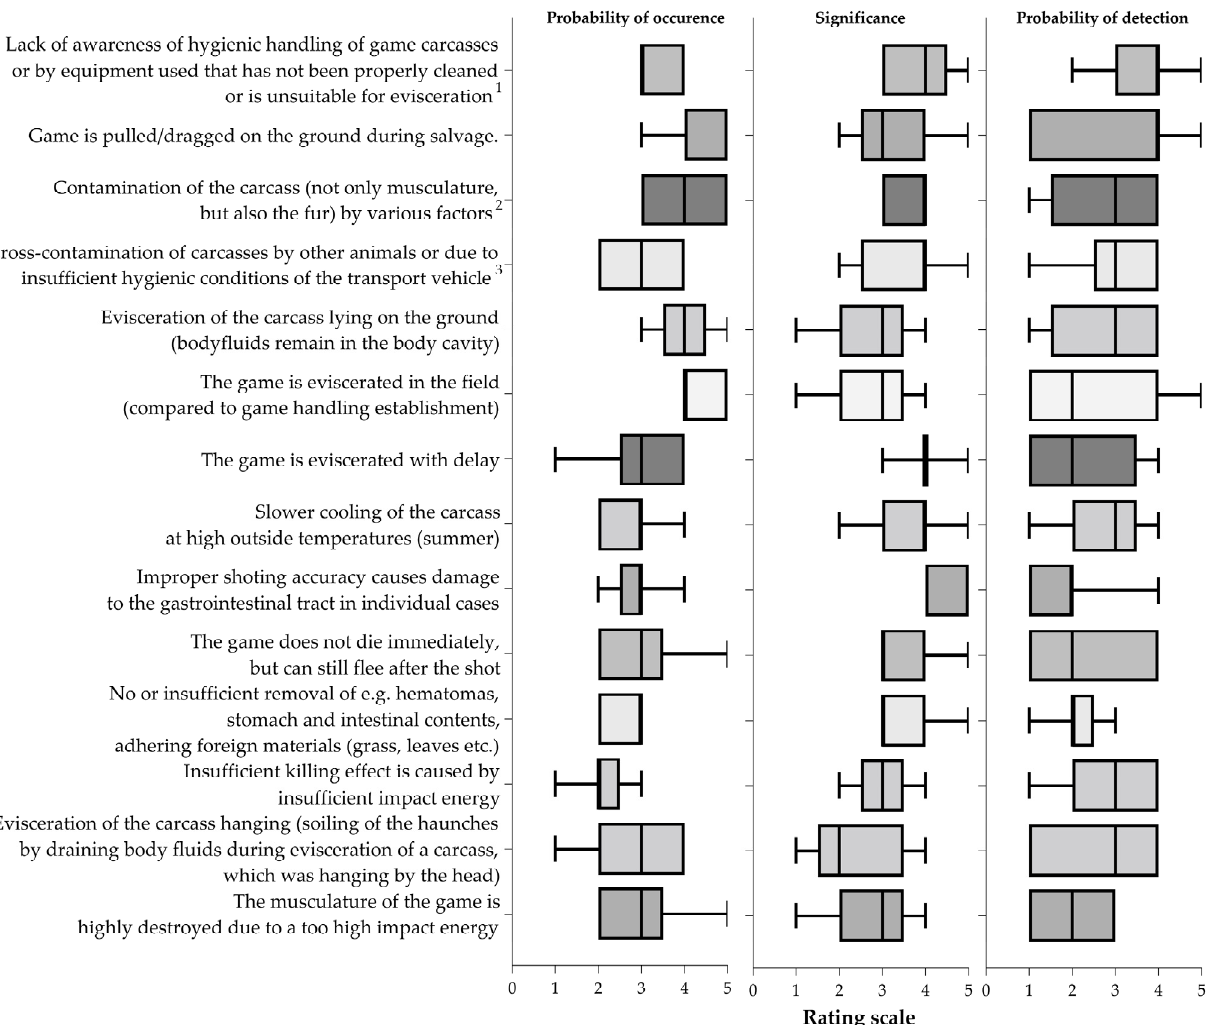
Figure 6. Boxplots show the variability of the probability of occurrence, significance and probability of detection rankings with minimum and maximum values for Failure and Mode and Effect analysis based on authors’ expertise. The subjects of the assessments including the footnotes for further specification: (1) contamination of carcass by, e.g., unwashed hands in the absence of running water or improper handling with gloves or unclean or blunt knives; (2) e.g., rain, grass, leaves, surface water, etc. on the ground when the tarpaulin is not in use or when the stomach and intestinal tract of the game are damaged during evisceration and the contents contaminate the carcass; (3) e.g., stacking or too close placement of several killed animals on a transport vehicle that is contaminated with soil, leaves, blood residues from eviscerated carcasses.